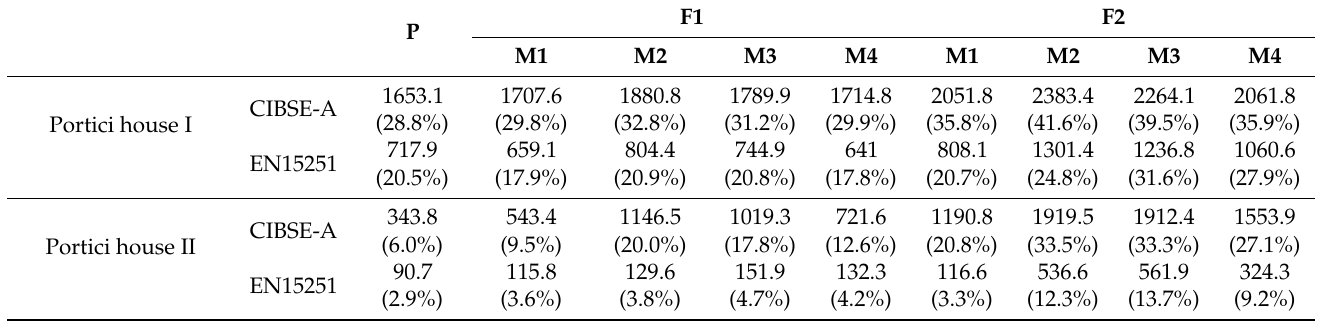
Table 7. Overheating hours/ratio of the retrofitted case, which is assessed with fixed operative temperature threshold (Method 1) and adaptive model (Method 2). P = 2008–2018, F1 = 2041–2050, and F2 = 2091–2100; M1–4 refer to the climate models in Table 2.